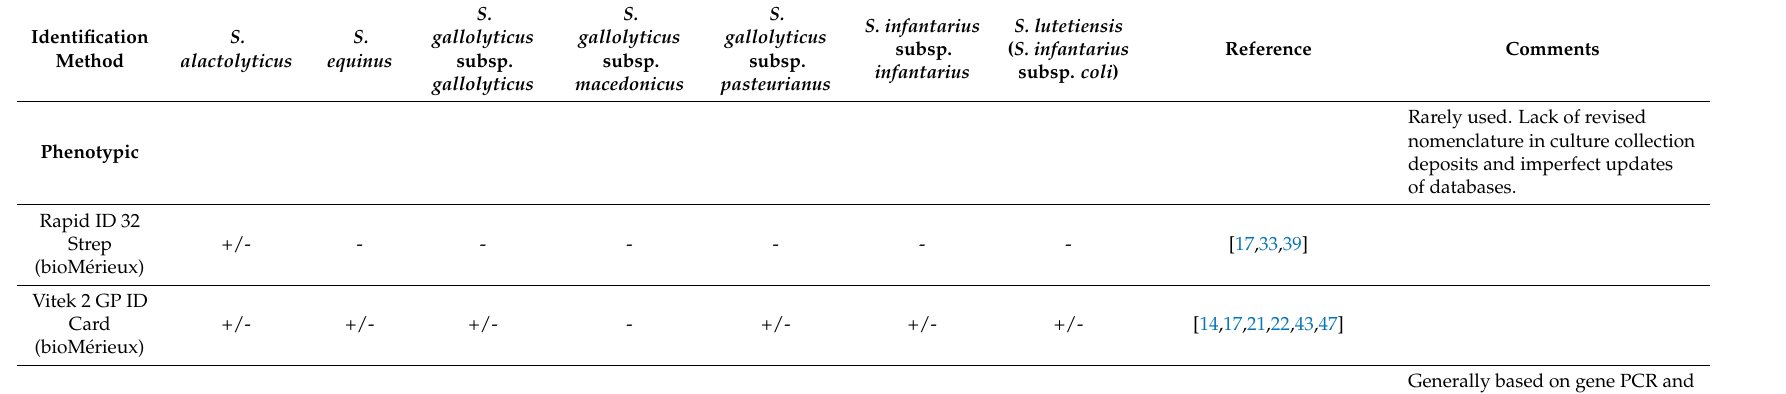
Table 1. Identification methods reported in the literature for SBSEC